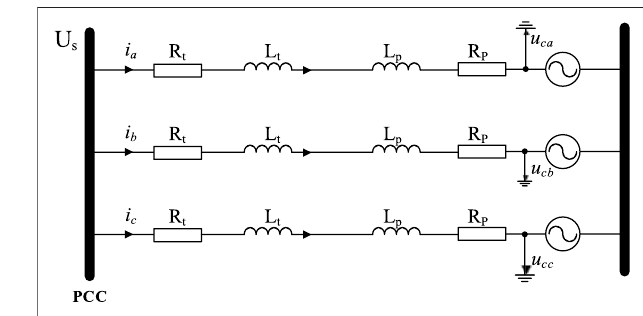
FIGURE 9 | The equivalent structure of a single MMC on the AC side.